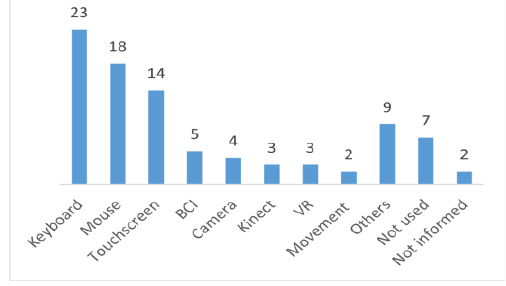
Figure 3. Control Devices.